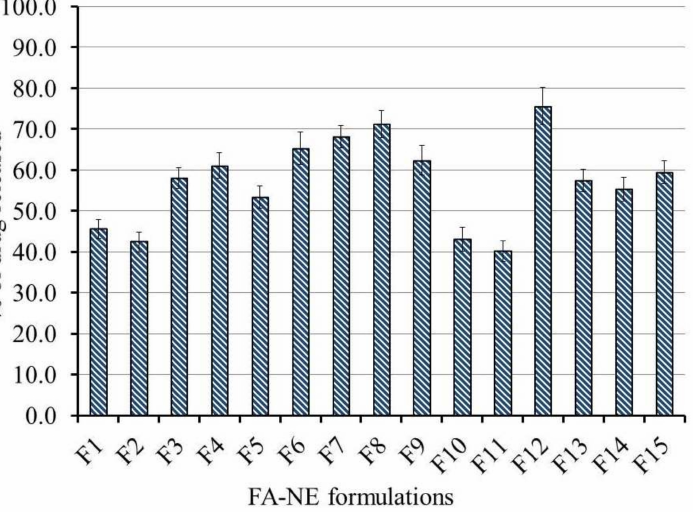
Figure 4. In vitro release of FA from various NE formulations kept at 32 ◦ C using pH 5.5 phosphate buffer for 6 h. Results are presented as the mean values of three determinations ±